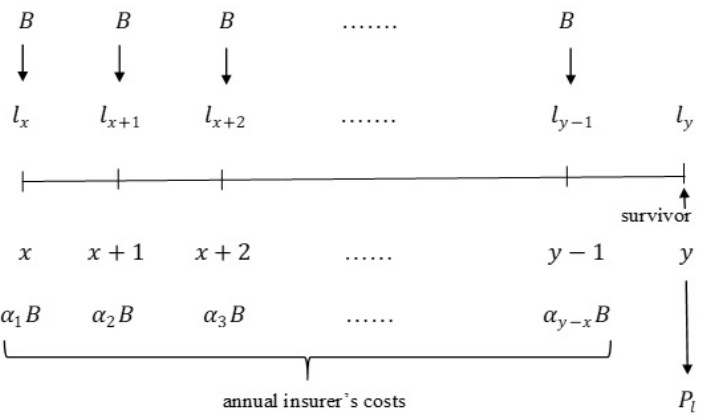
Figure 1. Schematic drawing of the accumulative pension scheme with annual contributions and a lump sum payment on retirement and without the possibility of